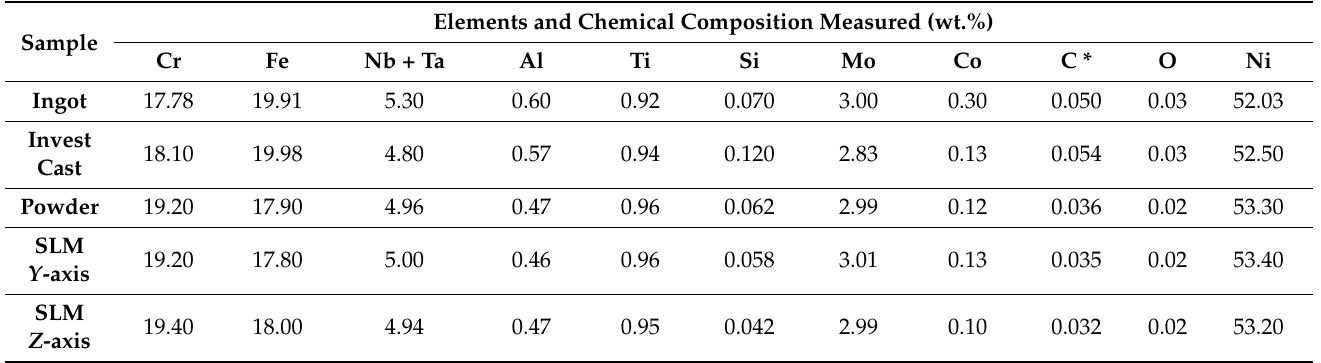
Figure 3. View of the mould and block samples obtained from investment casting process in IN718. ( a ) Mould in wax, ( b ) mould with shell after cast, and ( c ) mould without shell with integrated casts. Table 2. Chemical composition measured in the raw materials and in the manufactured samples. Elements and Chemical Composition Measured Sample